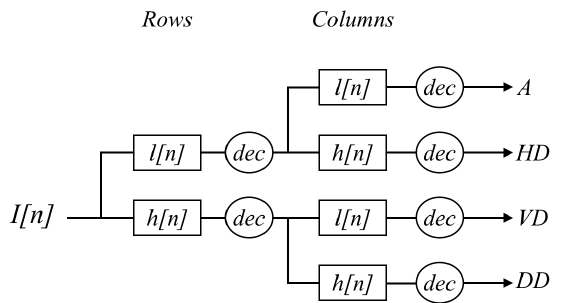
Figure 3. Two dimensional wavelet decomposition scheme ( l : low pass filter; h : high pass filter; dec :